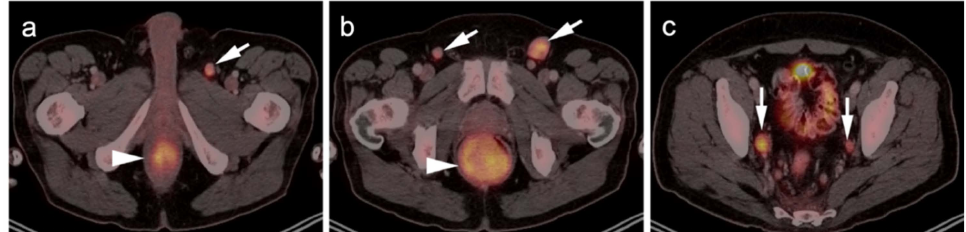
Figure 7. Anorectal melanoma. ( a , b ) Axial FDG PET-CT images of the pelvis. Metabolically active melanoma involving the rectum and anus (white arrowheads) with bilateral hypermetabolic inguinal nodes (white arrow). ( c ) Axial FDG PET-CT of the pelvis shows bilateral internal iliac hypermetabolic nodes (white arrows).